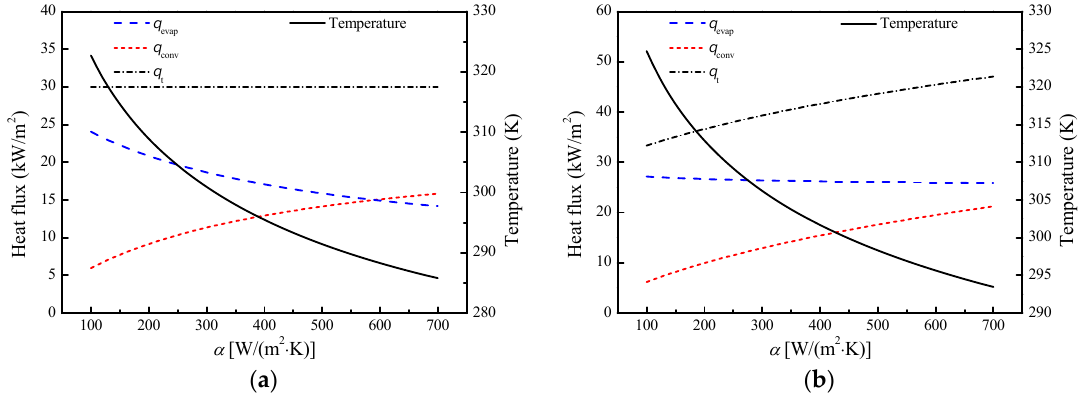
Figure 17. Changes of q evap , q conv and the surface temperature with α : ( a ) Constant q t ; ( b ) Constant . m ʹ evap